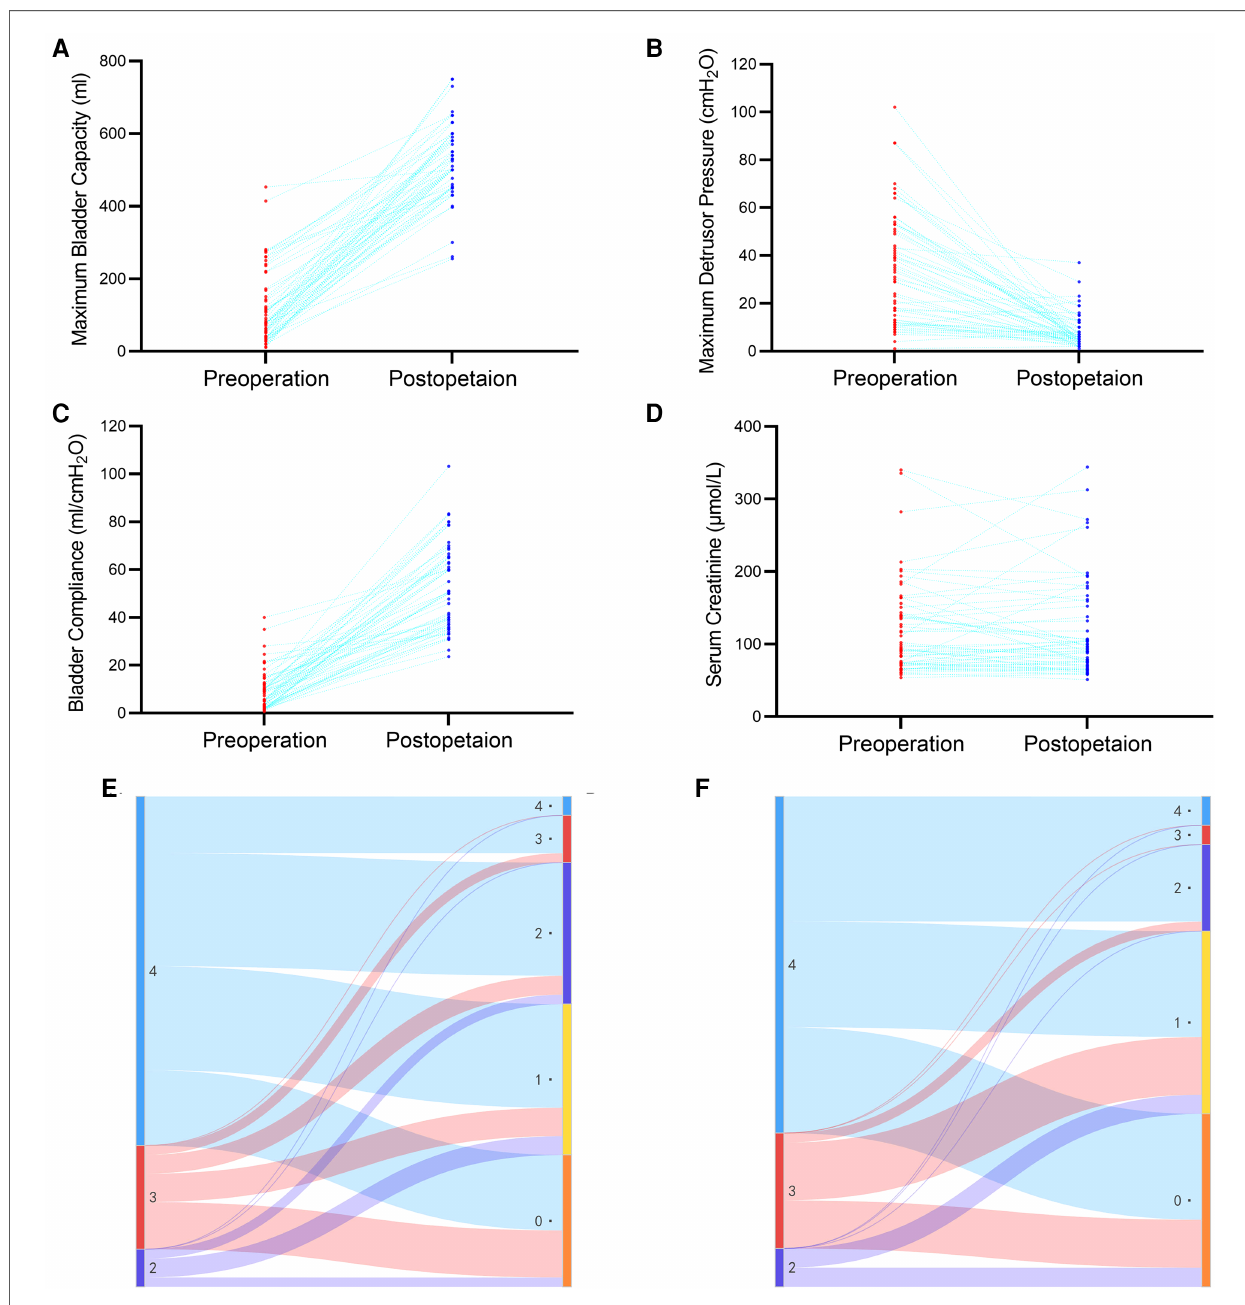
FIGURE 2 Changes in maximum bladder capacity ( A ), maximum detrusor pressure ( B ), bladder compliance ( C ), serum creatine ( D ), UUTD grades in the oUUTD ( E ) and roUUTD ( F ) group before and after